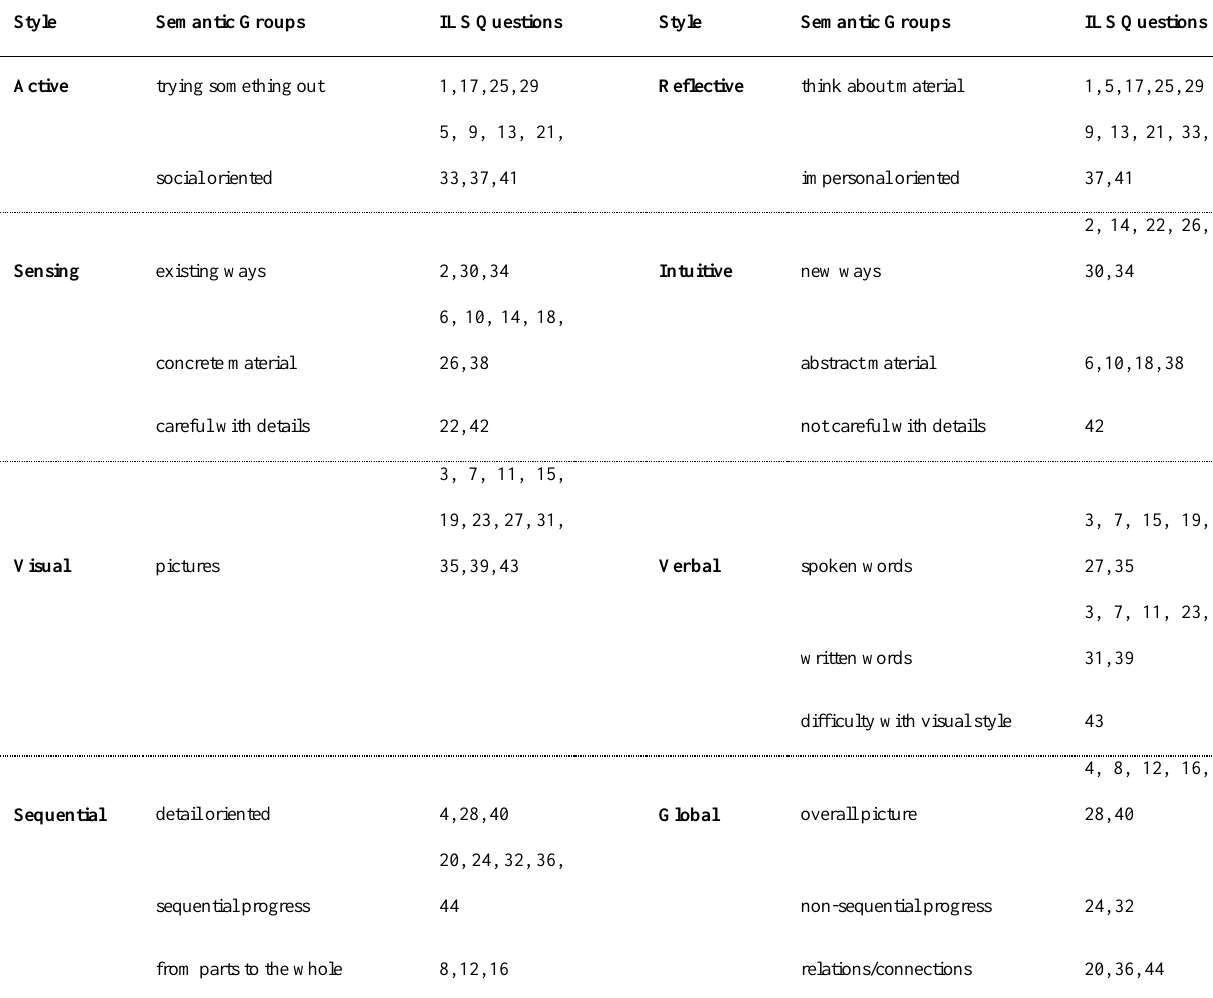
Table 1. Semantic groups associated with ILS questions of Felder and